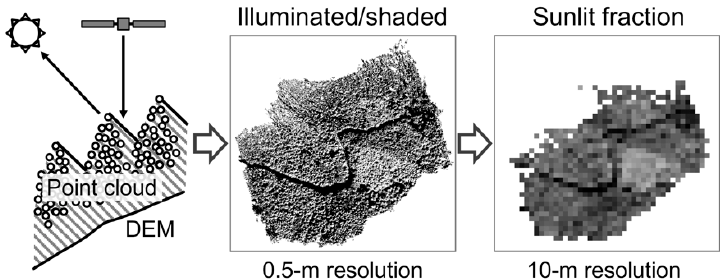
Figure 2. Calculation method of the sunlit fraction in the Sentinel-2 pixel. Pixels were eliminated along the edge due to the low density of the point cloud.